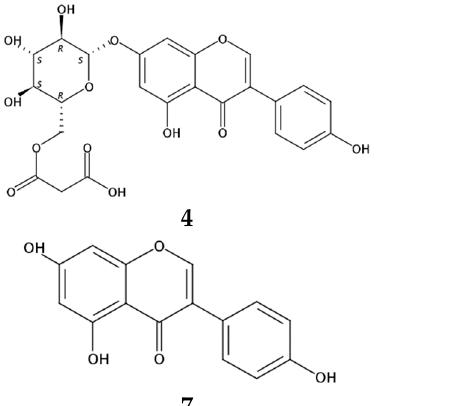
Figure 1. Structures of isolated and identified compounds from the roots of E. montanum. Preparative HPLC analysis was carried out on a Variant PrepStar machine. All extracts (500 mg) were dissolved in 30% methanol in distilled water. Samples were filtered through a 0.45 µm filter membrane before injection. The mobile phase consisted of trifluoroacetic acid (TFA) 0.05% in ultrapure water (solvent A) and acetonitrile (solvent B) as detailed in the Materials and Methods section. The gradient was obtained by transposing the analytical HPLC methods to preparative HPLC using HPLC calculator. The flow rate was 15 mL/min and the separation was monitored at 254 and 350 nm. Structural identification of isolated compounds was performed by 1D and 2D nuclear magnetic resonance (NMR) and infrared spectroscopy (IR) and by comparison to the literature.